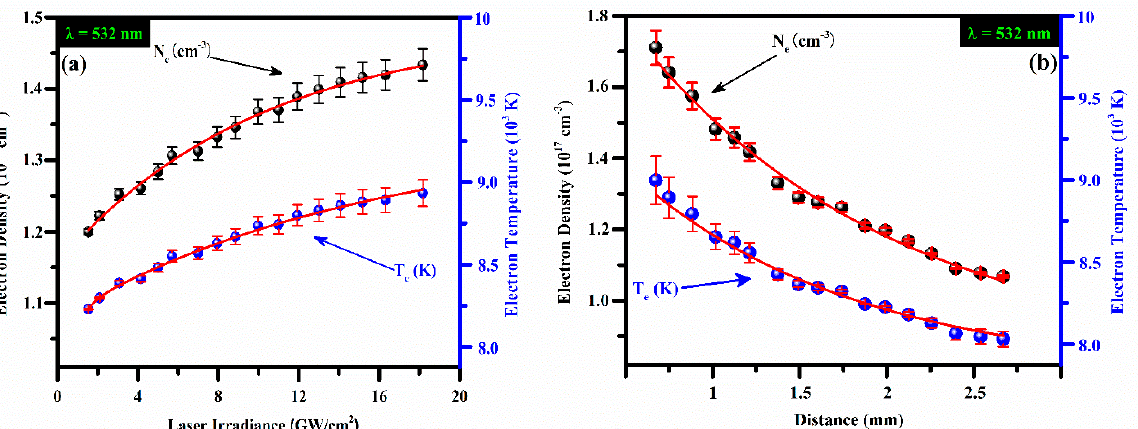
Figure 5. ( a ) The electron-temperature as well as electron number density of the plasma in a sample- ( α ) versus laser-irradiance ranges from 0 - 20 GW/cm 2 at 532 nm; ( b ) spatial varying behavior of the electron density and excitation plasma temperature in a sample-( α ).